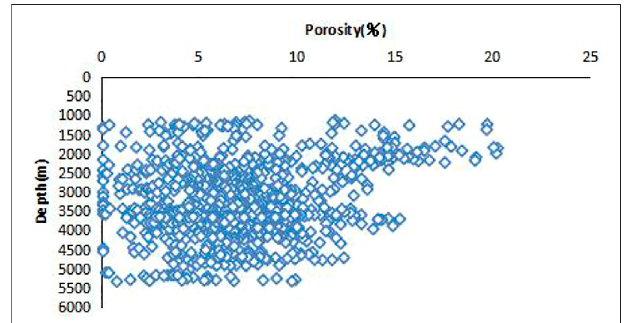
FIGURE 10 | Relationships between the porosity levels and the depths of the Upper Paleozoic reservoirs in the Dongpu Depression (Zhang, 2018).